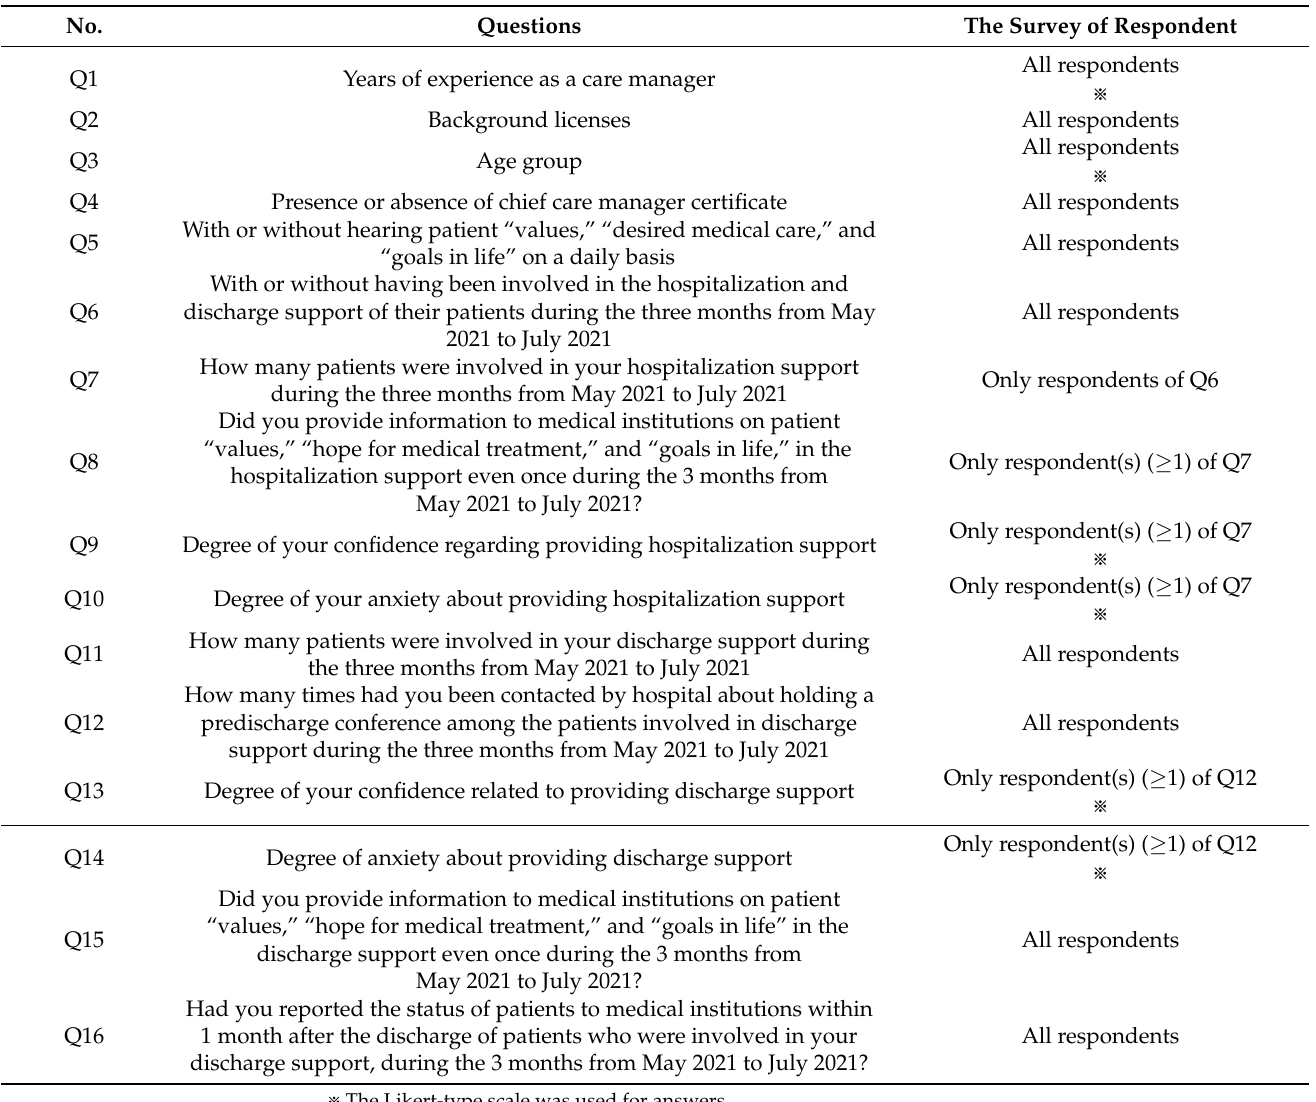
Table 1. A part of